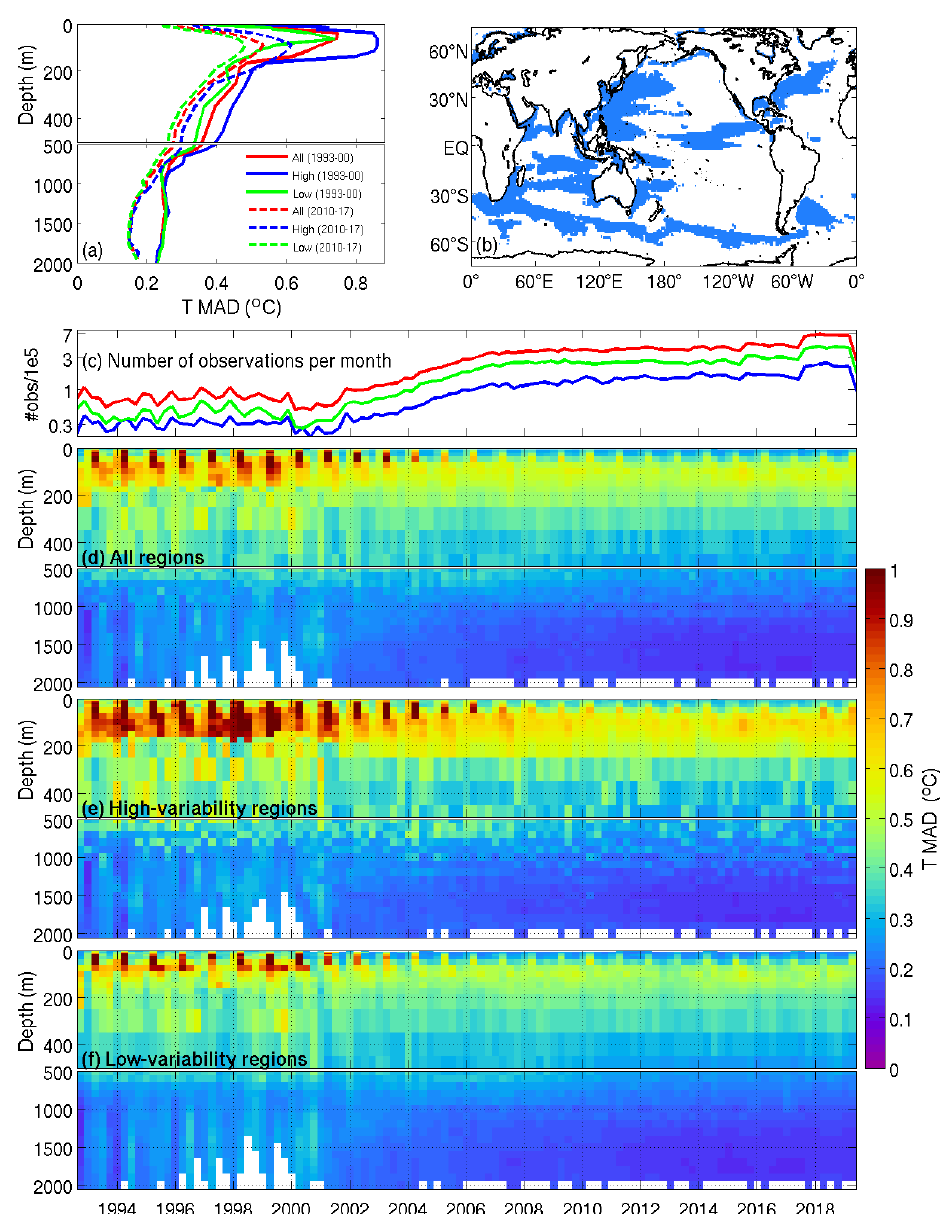
Figure 7. Mean absolute deviations (MADs) of temperature with depth over the course of BRAN2020. Results are shown for regions with high and low variability, as seen in sea level (shown top right) and combined. MAD profiles are at the top left, averaged over times before and after the full Argo array. Time series of the number of observations over BRAN2020 (log scale) is above Hovmöller diagrams of MAD for regions of low and high variability and